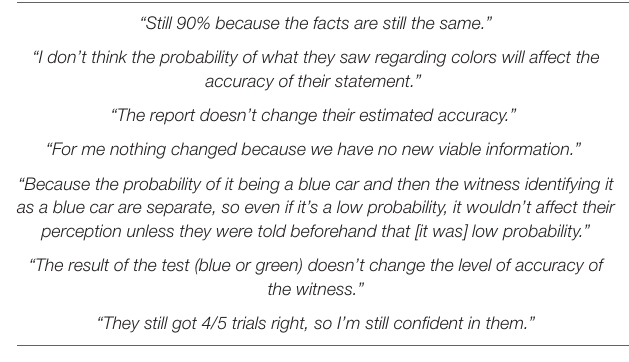
TABLE 4 | A selection of ‘No Change’ responders open text explanations of their reasoning assigned the code